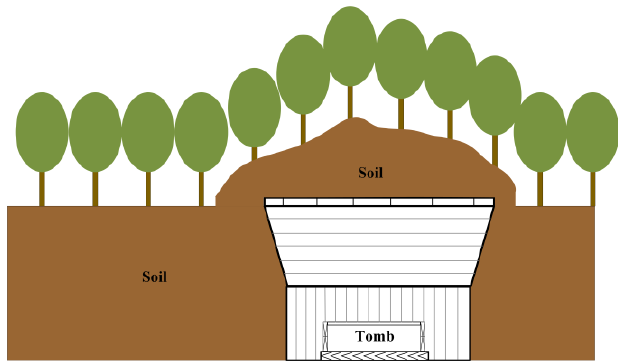
Figure 5. The profile of the ancient tomb from the ground to the